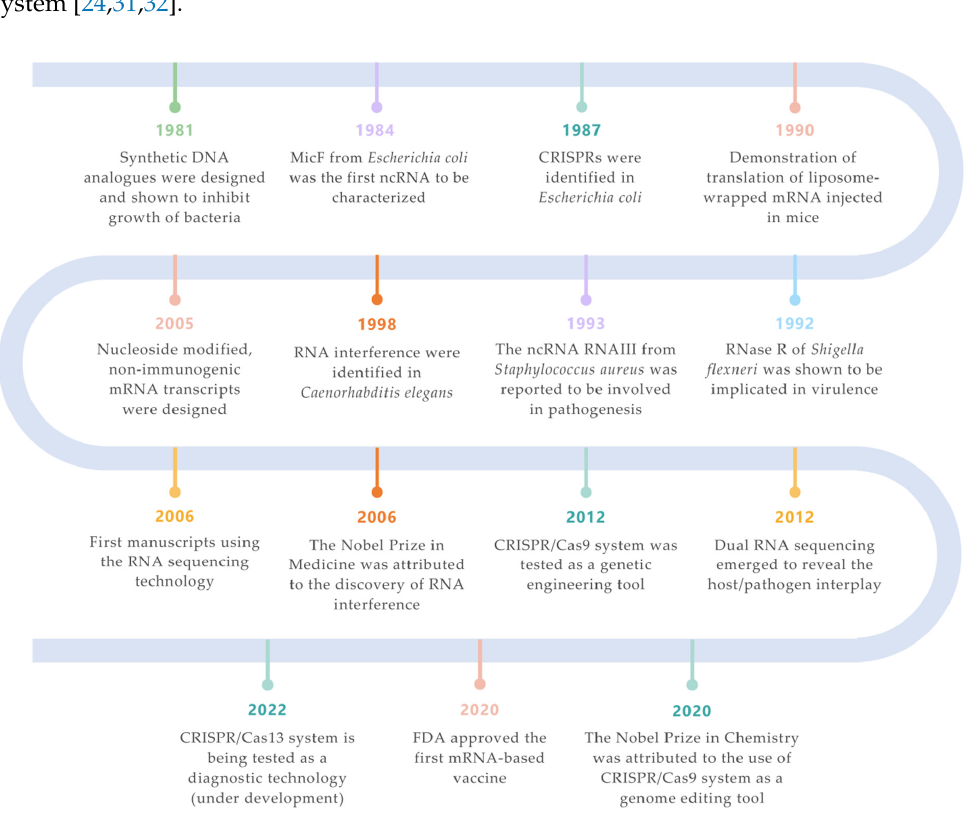
Figure 1. Landmarks on RNA technologies. An overview of the most relevant achievements and pioneer experiments around the RNA molecule. The timeline is color-coded for each field (green for synthetic biology; orange for siRNAs; purple for ncRNAs; turquoise for CRISPR/Cas systems; salmon for mRNA vaccines; yellow for RNA-seq technologies; blue for ribonucleases) [7,33–43].